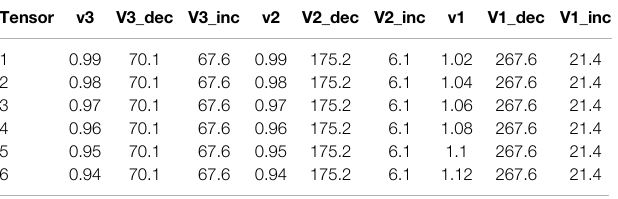
TABLE4| Listofthe “ unstraining ” tensorsappliedtothepaleomagneticdirections from